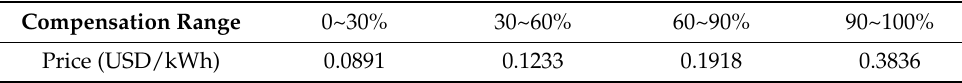
Table 2. Types of loads and losses in the node.